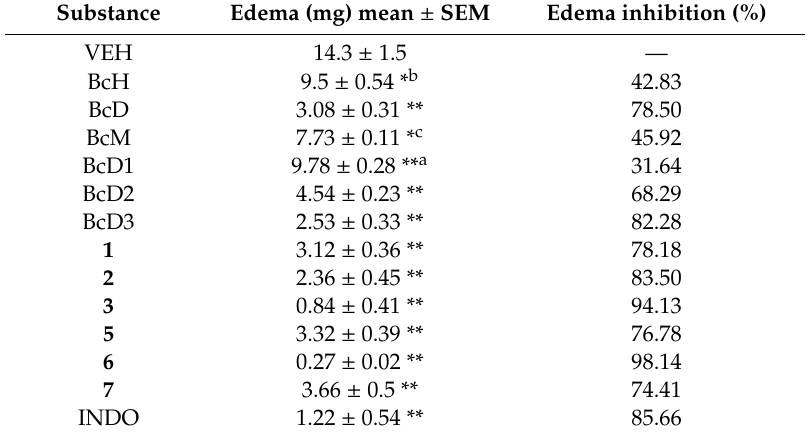
Table 1. Anti-inflammatory activity of extracts, fractions and compounds from B.